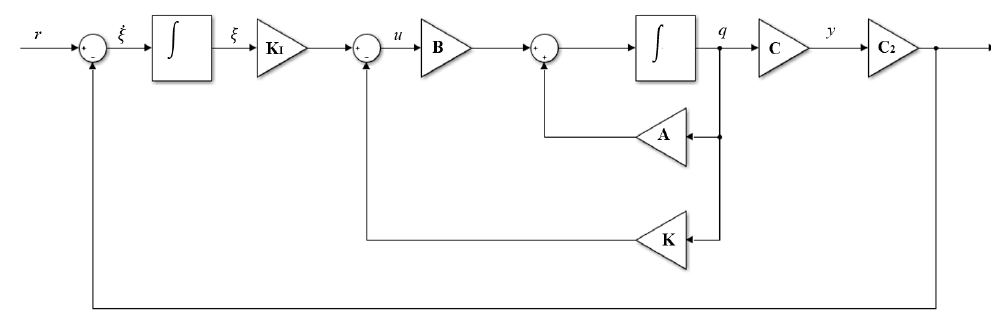
Figure 3. Type-one servo system for controlling the binary controlled variable stiffness actuator (BcVSA).